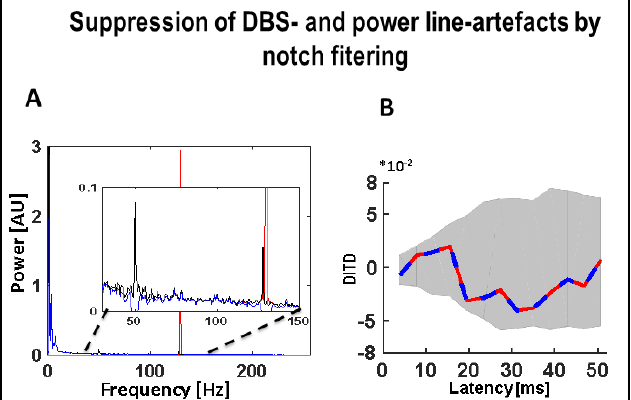
Figure 2. Effect of notch filters to suppress power line and DBS related artefacts. ( A ) Power spectrum of left PPN-LFP at base line (black line) with a simulated strong 130 Hz artefact (red line) superimposed. After notch filtering at 50 Hz and 130 Hz, the corresponding components are suppressed (blue line), the additional peak at 128 reflects environmental noise generated by surrounding medical equipment; ( B ) The difference of the DIT in the two directions (i.e., DITD = DIT (PPN L → PPN R *) − DIT (PPN R * → PPN L *)). Blue: DITD between the PPN-LFPs (without the simulated 130 Hz artefact) after notch filtering (50 Hz, 130 Hz). Red: DITD between the PPN-LFPs (both including superimposed simulated stimulation, DIT: directed information transfer, LFP: local field potentials, PPN: pedunculopontine nucleus region ( L = left, R = right, * denotes clinically more affected